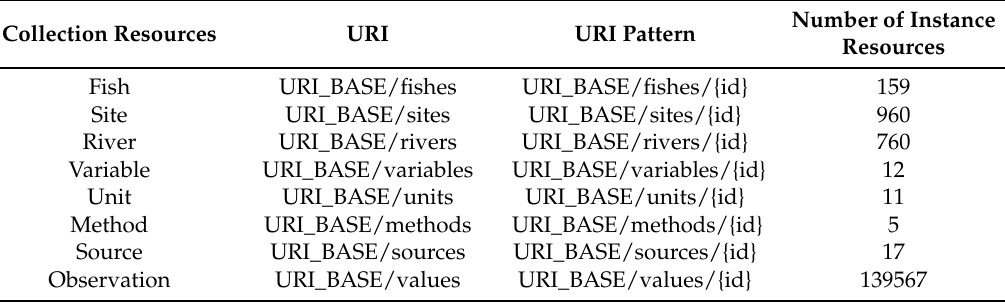
Table 2. URIs and URI patterns for the collection